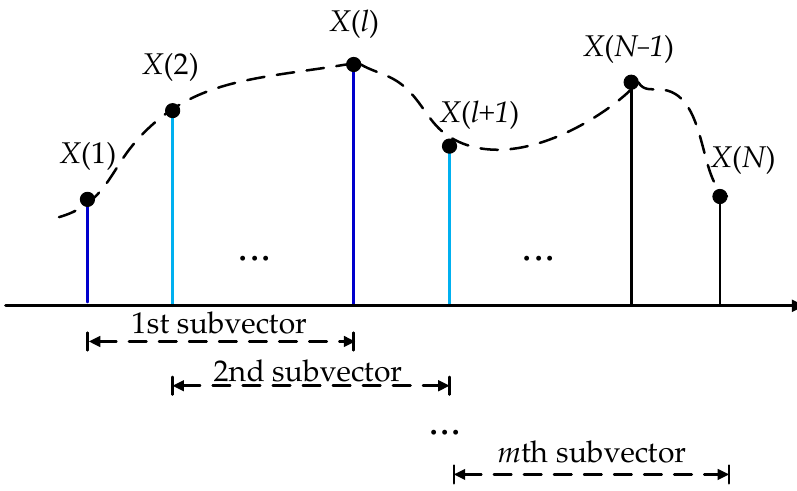
Figure 8. Schematic diagram of bandwidth division of echo signal.